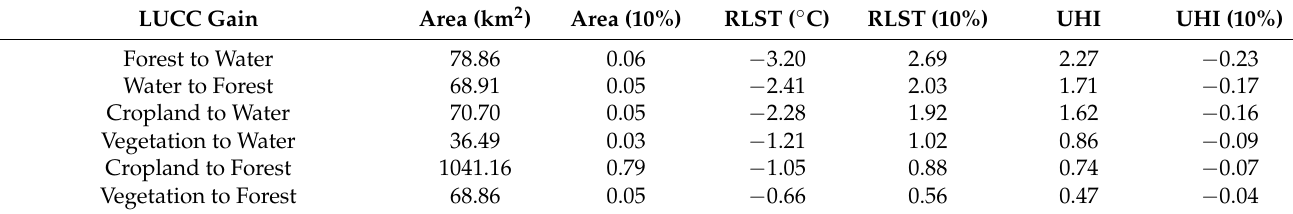
Table 8. The LUCC cooling effect, percentage rise in surface temperature, and standardized percentage contribution (10%) to urban heat islands